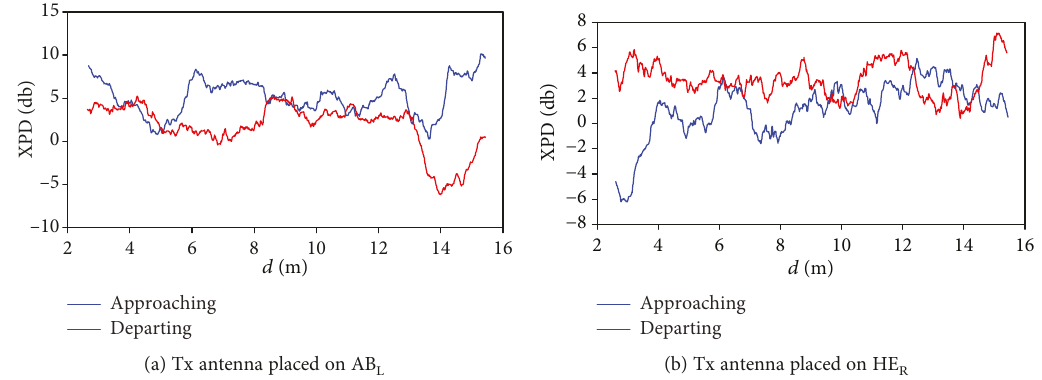
Figure 7: XPD vs. length of the propagation path ( d ) for approaching and departing scenarios.